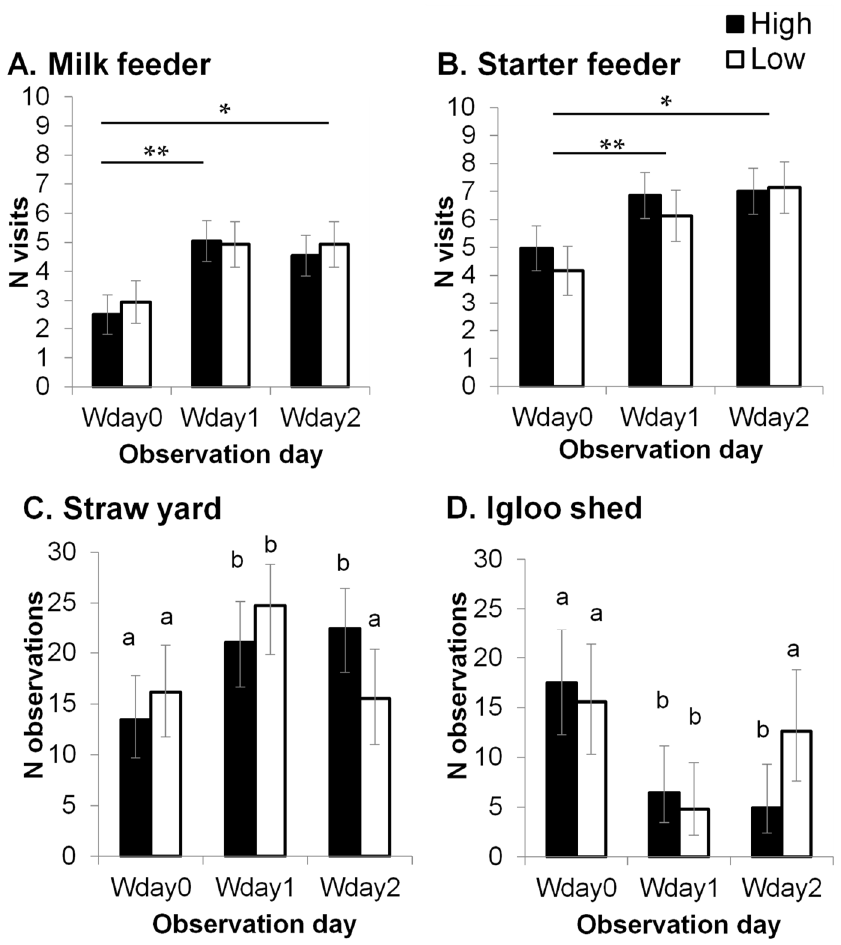
Figure 2. The number of milk feeder ( A ) and starter feeder ( B ) visits (predicted means ± SEM), and the number of times a calf was observed in the straw ( C ) and in the igloo shed ( D ) (back-transformed means and 95% Cis (confidence intervals).) before weaning started (Wday 0), in the middle of weaning (Wday 1) and when weaning was completed (Wday 3). *: significant di ff erence between Wday 0 and Wday 2 ( p < 0.01). **: significant di ff erence between Wday 0 and Wday 1 ( p < 0.001). a,b : di ff erent letters indicate significant di ff erences ( p < 0.05).